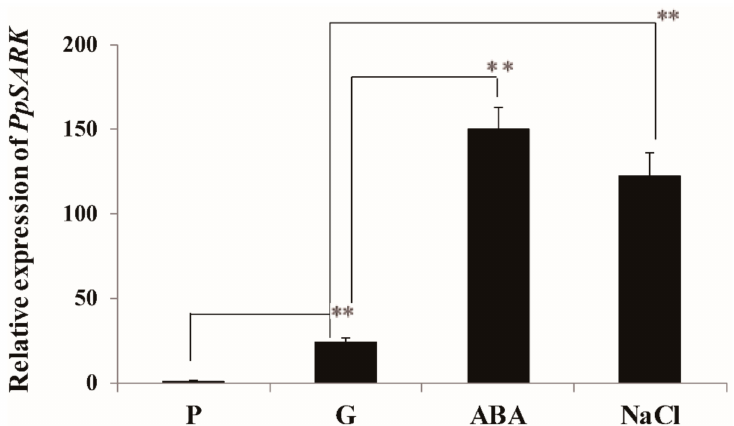
Figure 1. SARK isolated from Physcomitrella patens ( PpSARK ) is a development-associated gene induced by abscisic acid (ABA) and NaCl. P—protonema tissue at five days old; G—gametophyte at one month old. The gametophyte was treated with ABA and NaCl. Data are represented as means ± SD, n = 3. The t -test was used and an asterisk indicates that the value of treatment is different from the control; ** p <